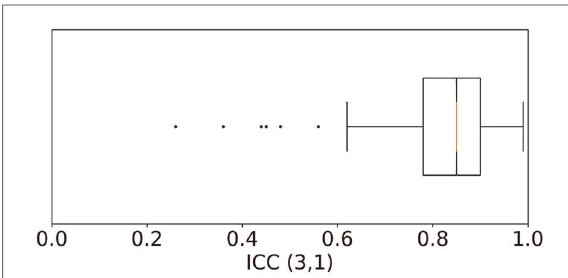
FIGURE 6 Box plot of the Intraclass Correlation Coef fi cient — ICC (3,1) as de fi ned by Shrout and Fleiss (26) — comparing the quality fi ltered in-ear heart rate data to the heart rate from ECG over all 97 patients. Each recording was weighted by its duration. The median is at 0.85. 50% of the data points lie within the range of 0.78 – 0.9. Six outliers that score lower than 0.62 were identi fi